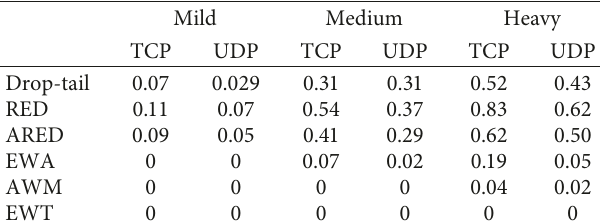
Figure 15: Goodput fairness: Scenario 2. Table 6: Mean loss ratio of TCP and UDP: Scenario 2.